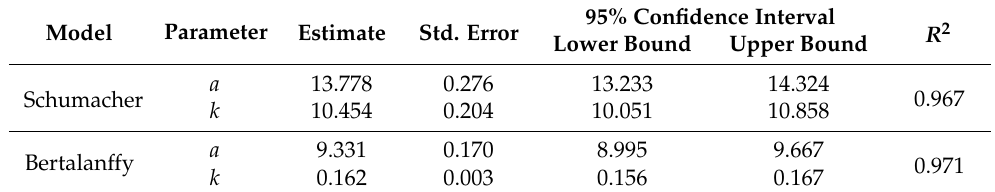
Table 5. Results from the numerical interactions using the software IBM ® SPSS Statistics.